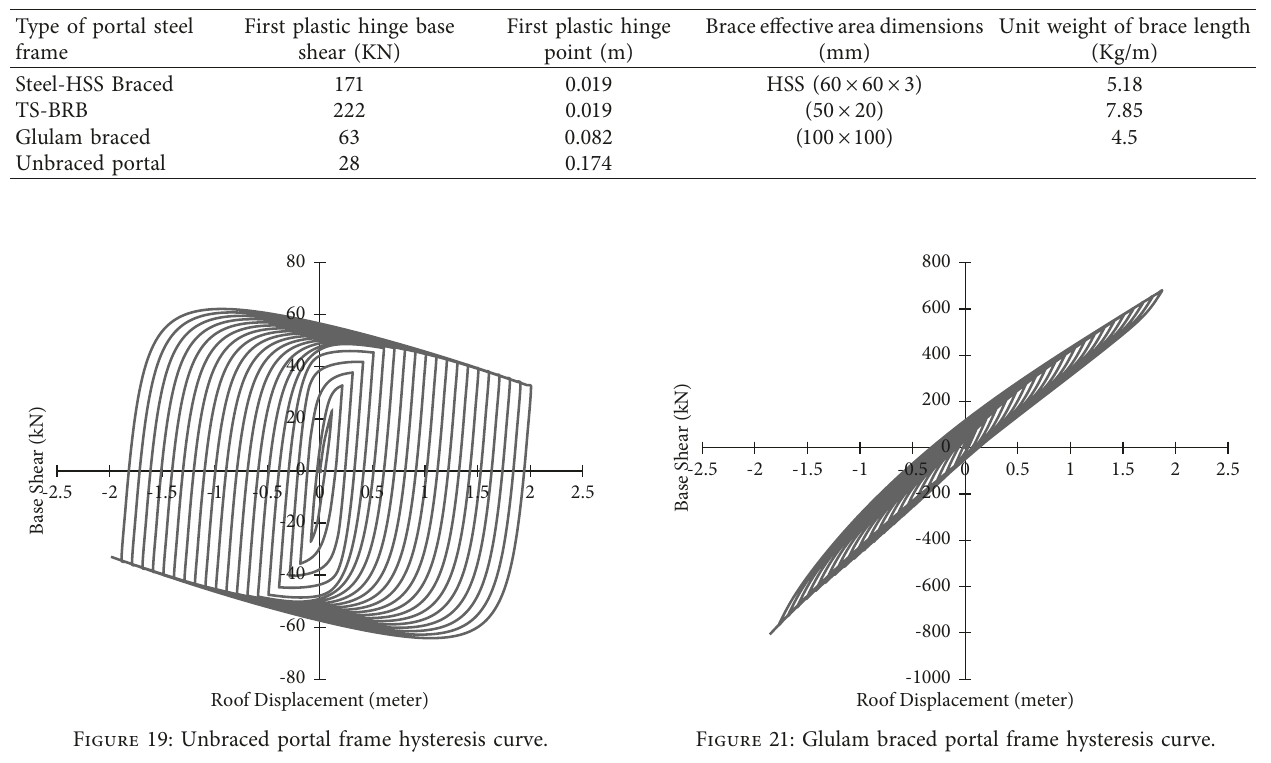
Table 5: Summery of base shear equivalent to the first plastic hinge formation of different frames.